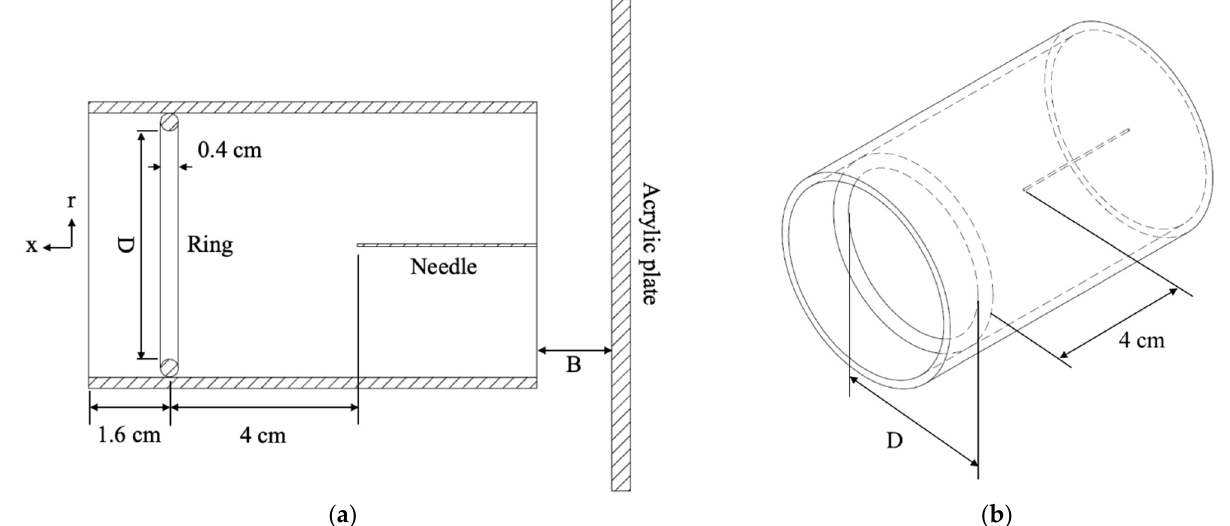
Figure 2. The schematics of the experimental setup and the ionic wind pump under test. ( a ) Experimental setup (center cut-plane view) and ( b ) ionic wind pump (iso view). D represents the pump size (inner diameter of the ring), and B represents the blockage distance.